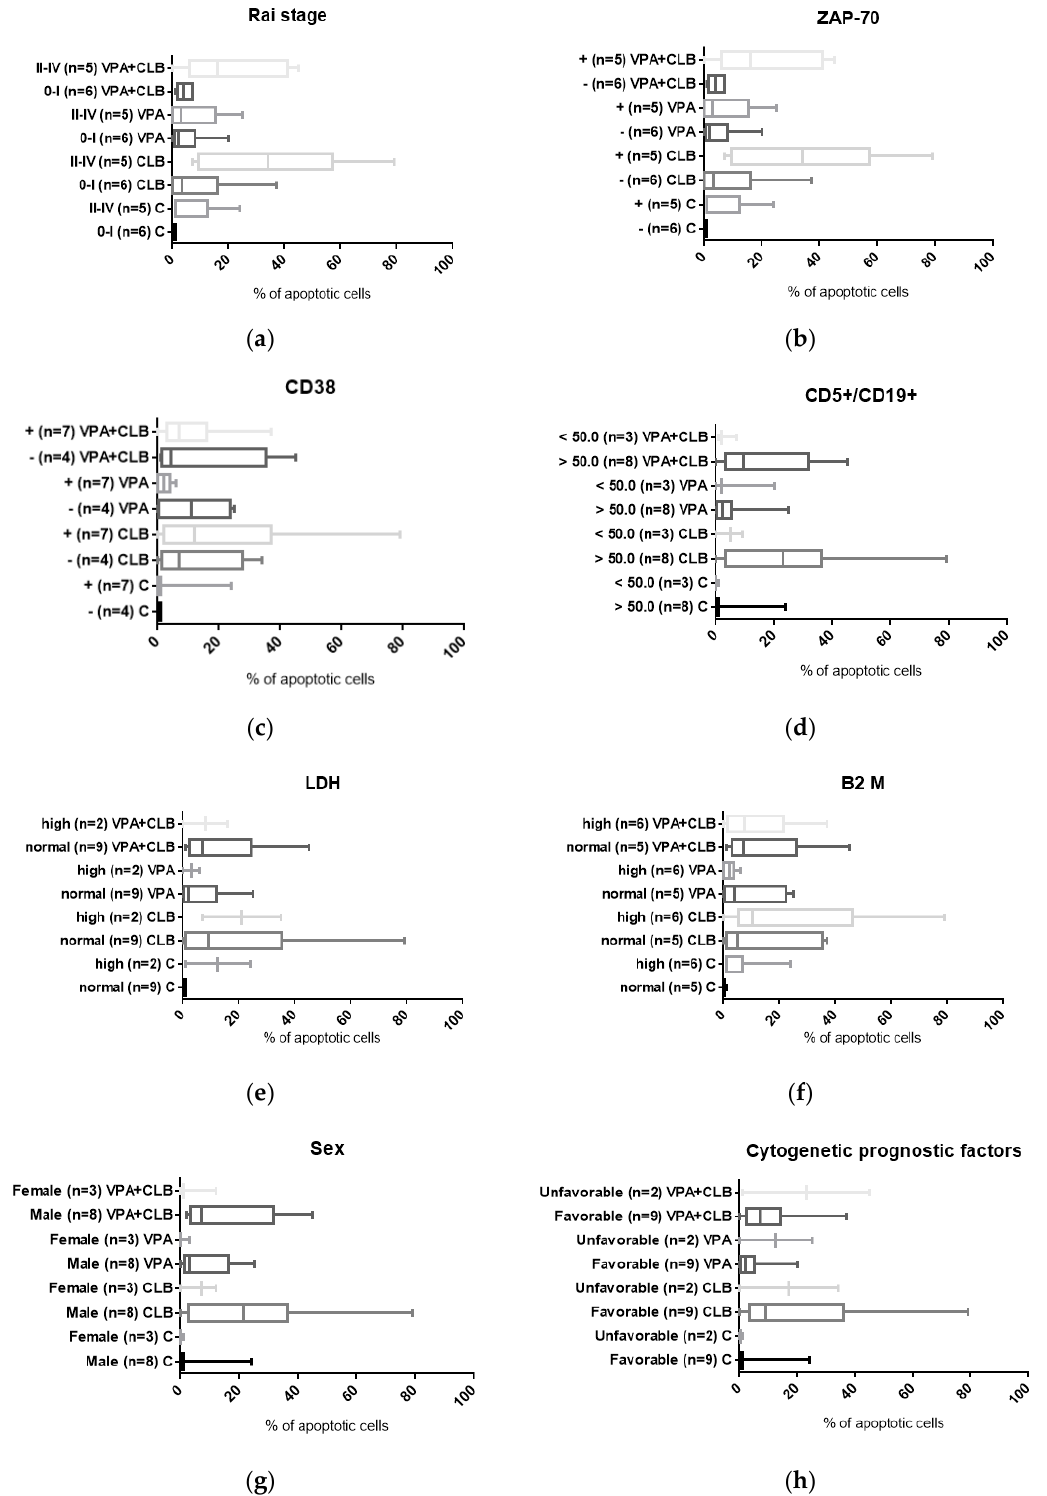
Figure 3. Apoptosis of CLL cells cultured with CLB and VPA combination after 24 h for patients no. 7–17 ( n = 11). The graphs show differences: ( a ) among patients with different Rai stage, ( b ) between subgroups of patients with positive and negative ZAP-70 expression, ( c ) among patients with positive and negative CD38 status ( d ) between subgroups of patients with different count of CD5 + /CD19 + lymphocytes, ( e ) among patients with normal and high LDH concentrations, ( f ) among patients with normal and high B2 M concentrations, ( g ) between men and women and ( h ) between subgroups of patients with favorable and unfavorable cytogenetic prognostic factors.